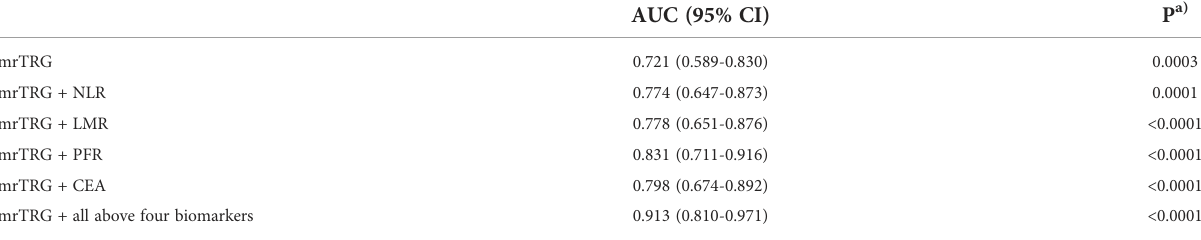
TABLE 4 AUC values of each roc curve.